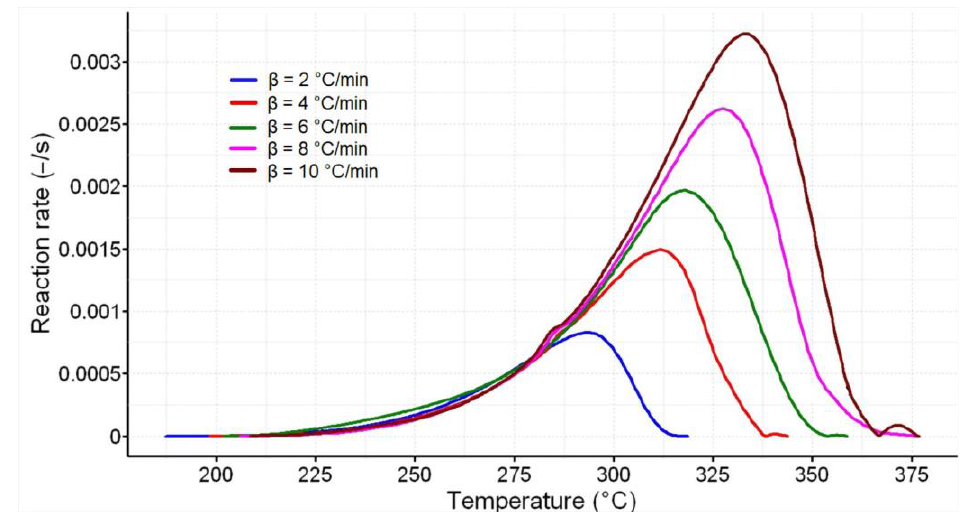
Figure 6. The reaction rate vs. temperature dependence for thermal decomposition of EE; curve 1 corresponds to β = 2 °C/min, curve 2 to β = 4 °C/min, curve 3 to β = 6 °C/min, curve 4 to β = 8 °C/min and curve 5 to β = 10 °C/min, respectively.